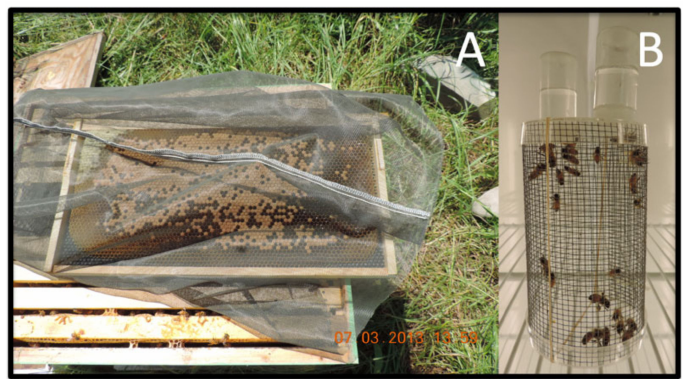
Figure 3. Mesh bag over frame of sealed brood ( A ), and cage and sugar syrup vials for holding newly emerged workers ( B